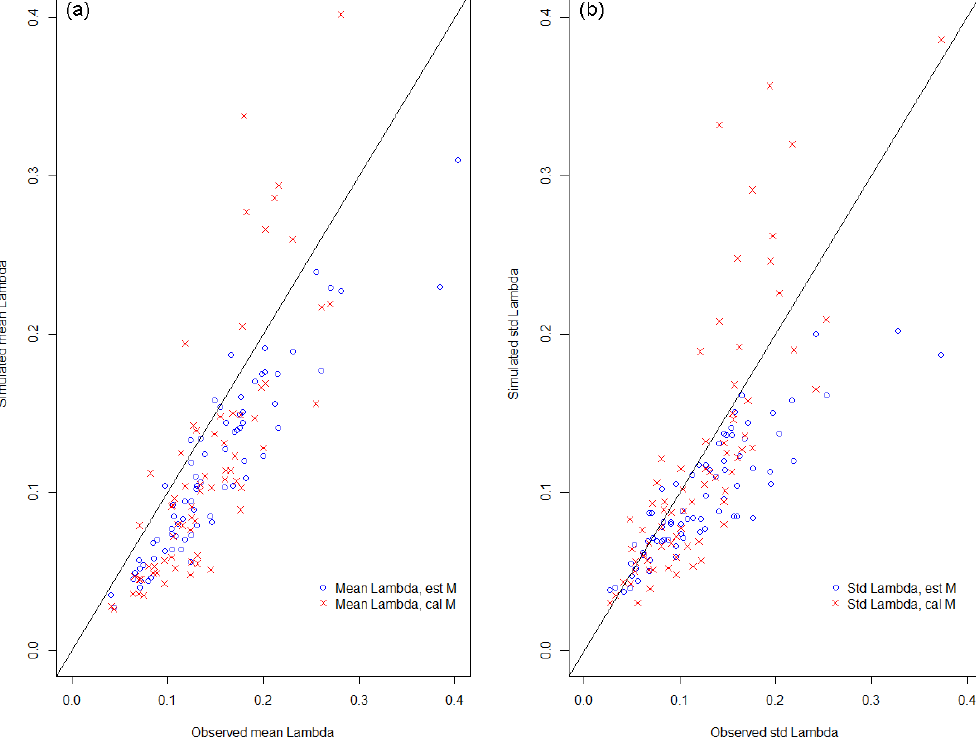
Hydrol. Earth Syst. Sci., 20, 4963–4981, 2016